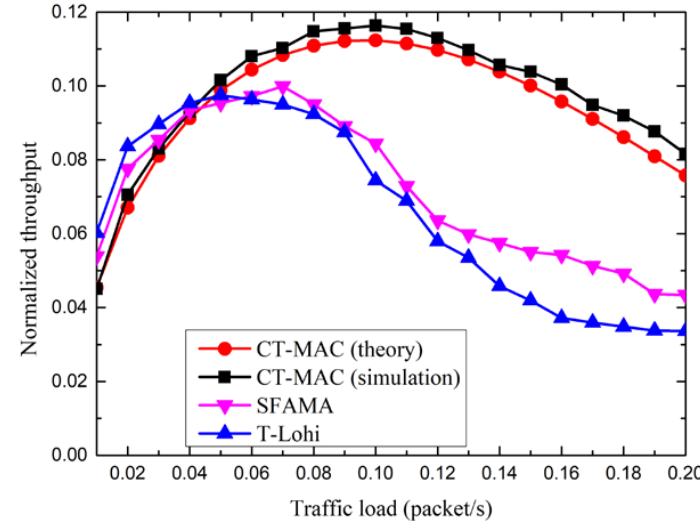
Figure 11. The normalized throughput of the CT-MAC protocol in sub-topology.